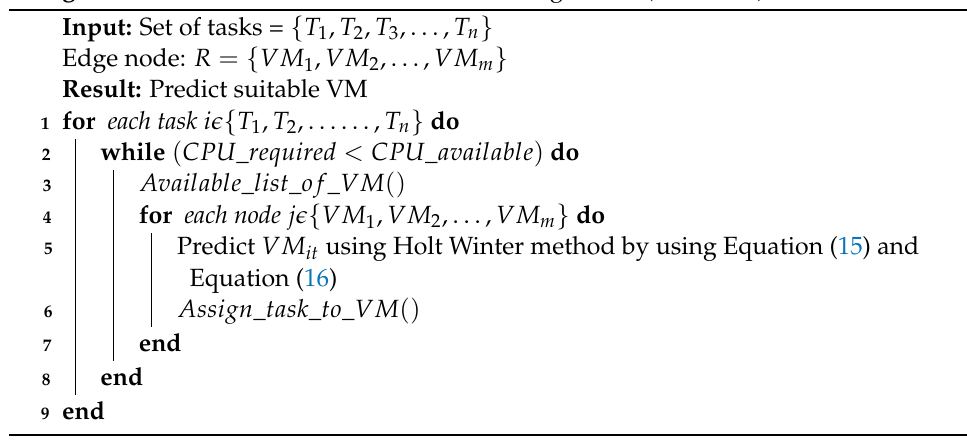
Algorithm 2: Holt–Winters-based univariate algorithm (HWVMR)